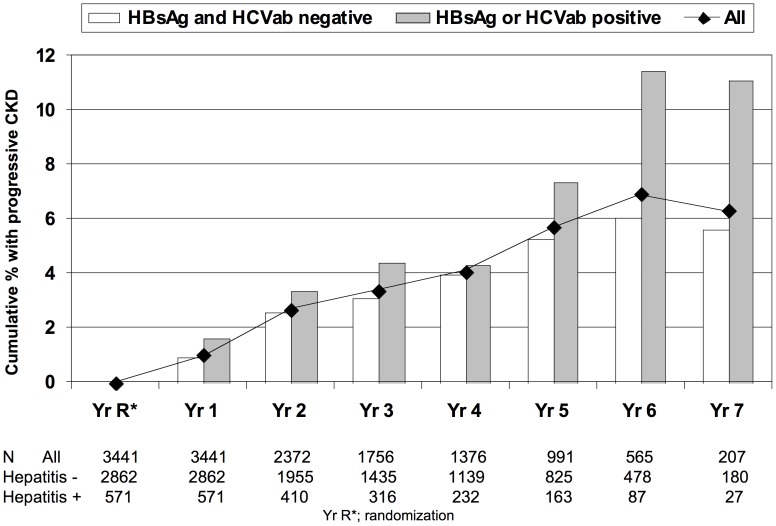
Cumulative proportion of participants with progressive kidney disease.